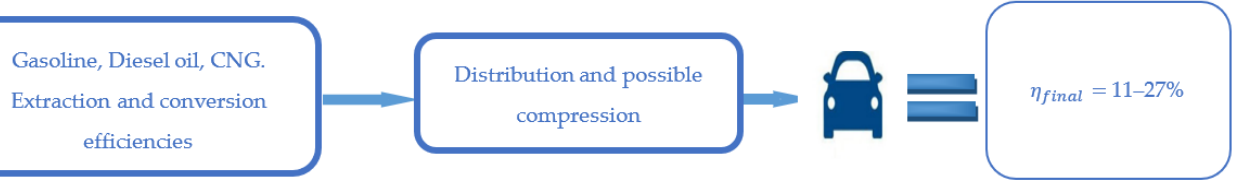
Figure 5. The final efficiency of EVs’ charging considering the electricity coming from PV. On the other hand, Scenario 2 is focused on the path to decarbonizing and further lowering the CO 2 emissions by exploiting as much as possible renewables: indeed, the present study analyses the impact coming from the penetration of 30% and 90% EVs in the national energy system of Pakistan by investigating the effects of different charging options. Per each scenario, two different PV capacities in Pakistan during the daytime have been calculated according to the forecasted PV, considering the two different levels of EVs’ penetration previously mentioned. The studied scenarios are the following [13]: 1. 30% EVs fleet penetration by adding small and medium vehicles (year 2030); 2.